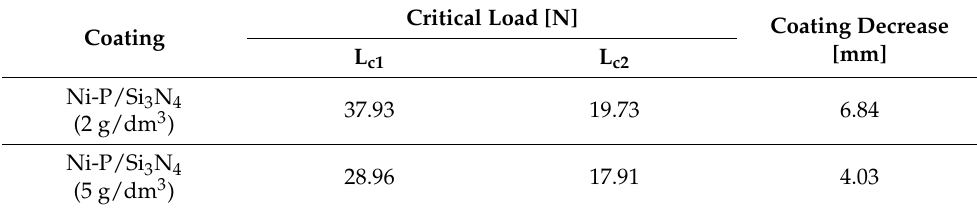
Table 9. Critical loads for the tested chemical